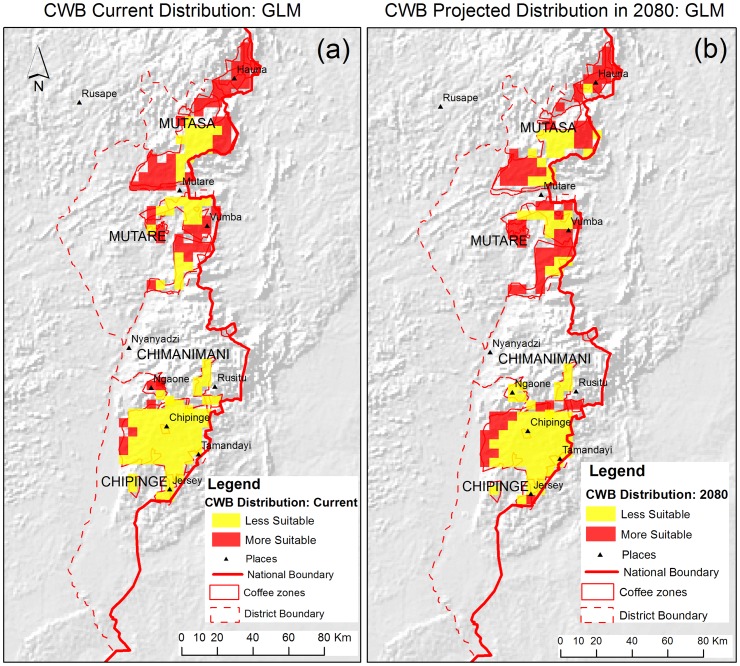
Distribution of CWB in coffee zones from GLM.
Figure 4(a) shows the current distribution of CWB from the GLM. Figure 4(b) shows the projected distribution of CWB from the GLM. The red zones are areas with a probability of occurrence above 0.5 indicating CWB is likely to occur and the yellow zones are areas that have a probability below 0.5 indicating CWB is less likely to occur.